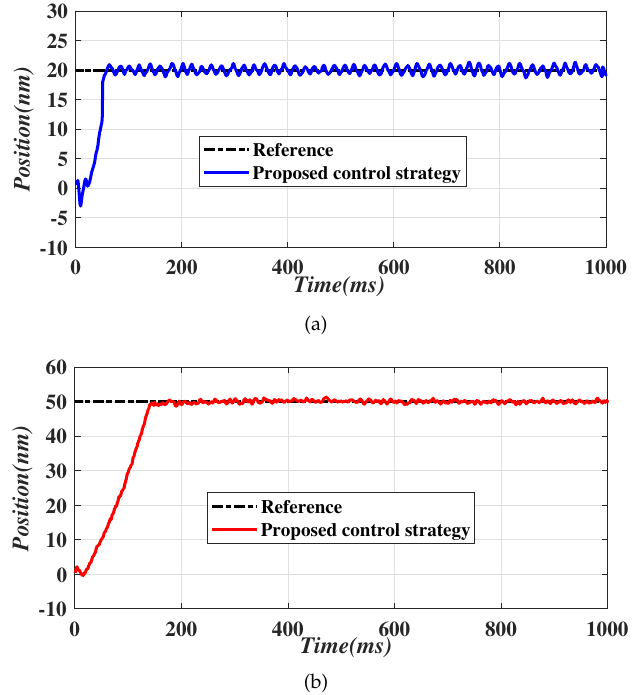
Figure 10. Tracking curve under the proposed composite control strategy. ( a ) Reference = 20 nm. ( b ) Reference = 50 nm.